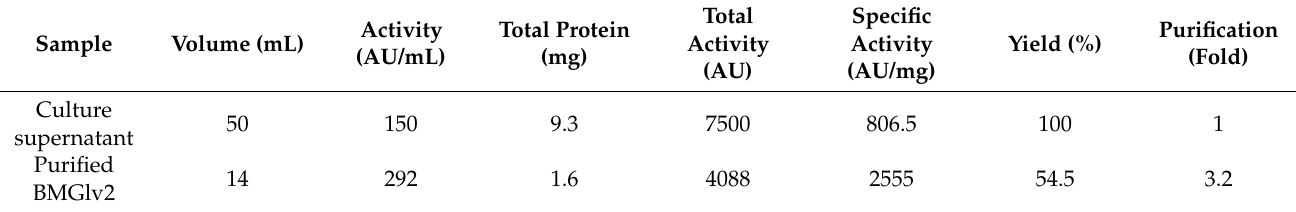
Table 1. Purification of recombinant of BMGlv2.